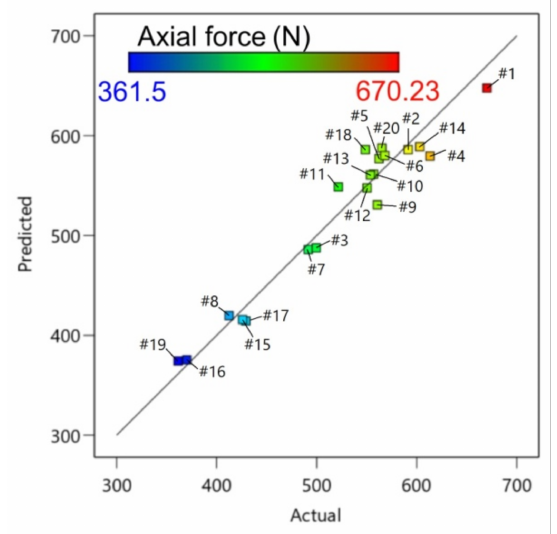
Figure 7. Predicted versus actual response for axial forming